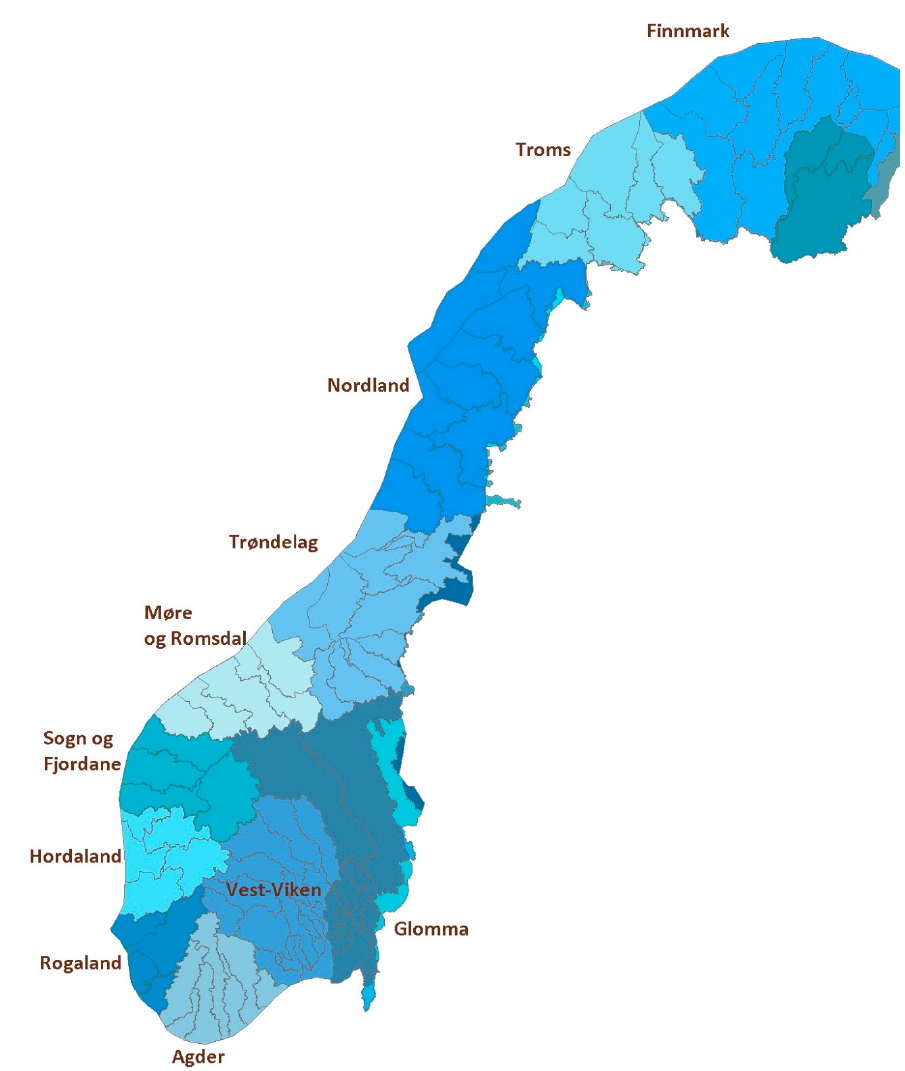
Figure 1. The Norwegian River Basin Districts. Source: http: // www.vannportalen.no / organisering / vannregioner /